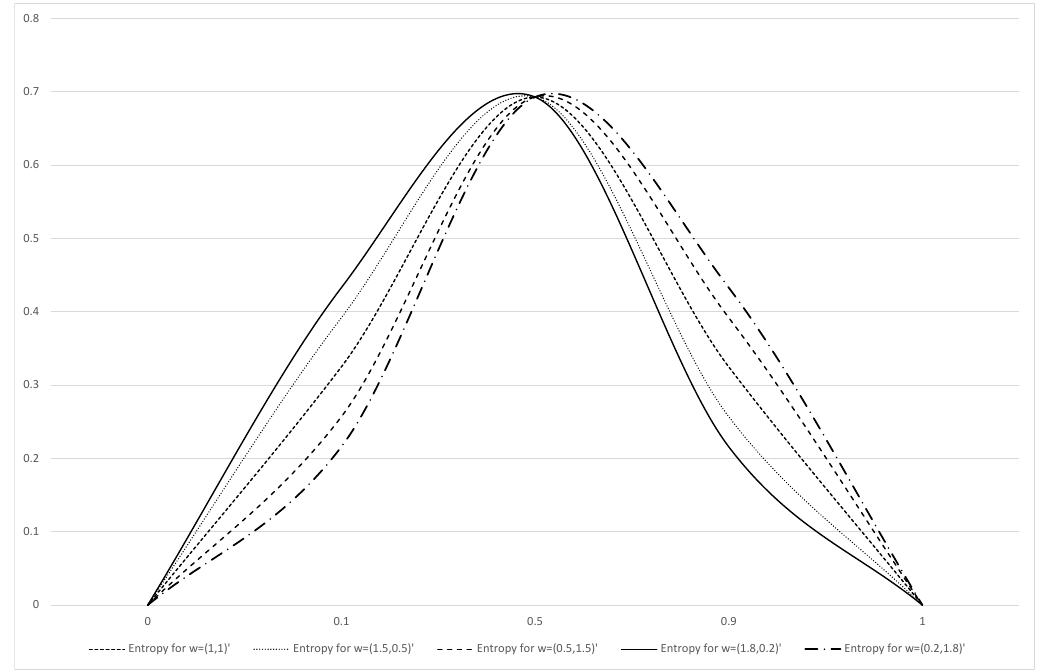
Figure 1. Weighted Shannon Entropy of Bernoulli trials.